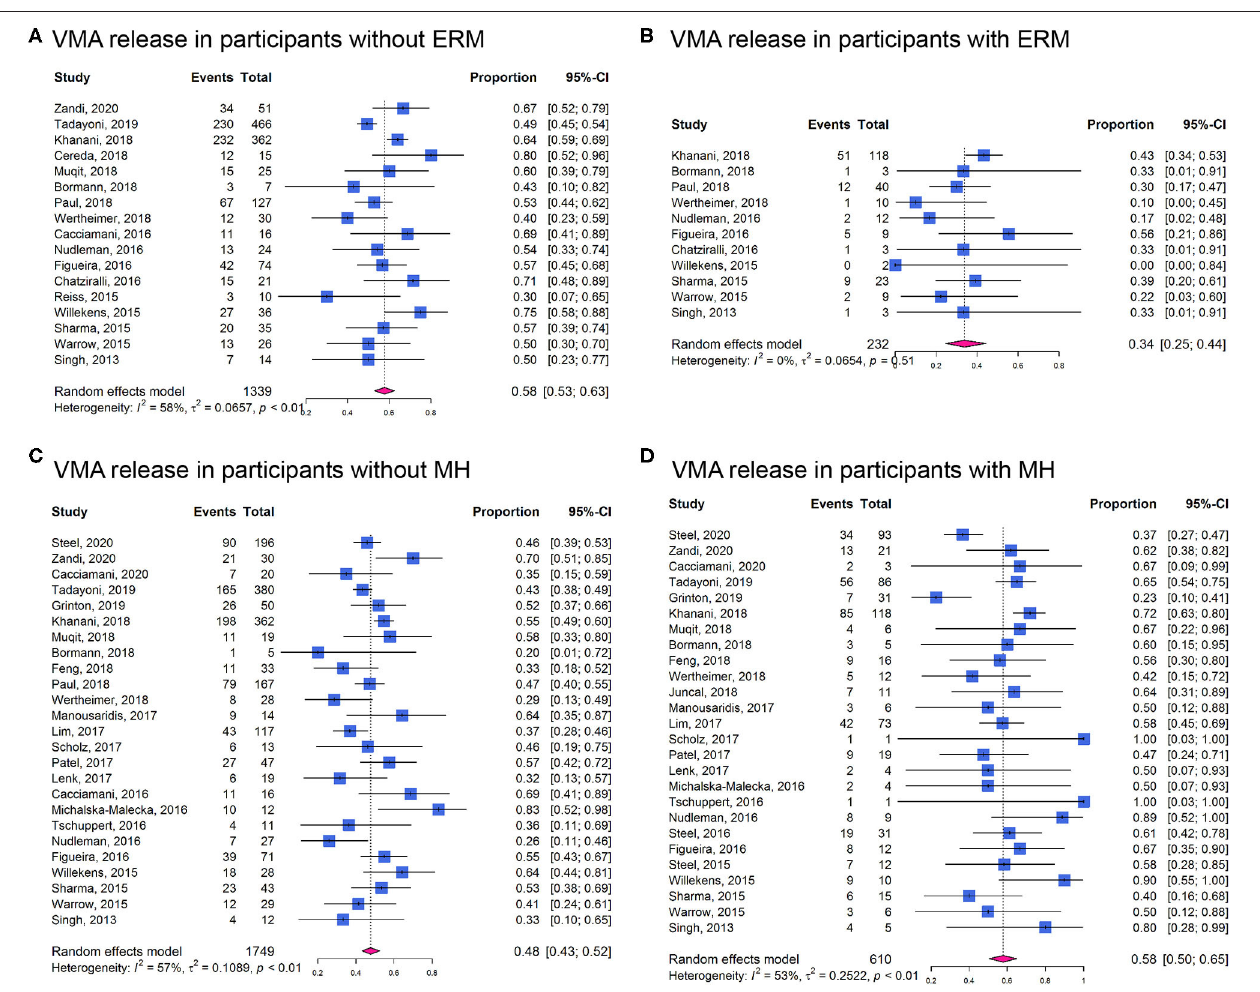
FIGURE 4 | Forest plots of proportion of VMA release in participants receiving ocriplasmin therapy in different groups. (A) In participants without epiretinal membrane (ERM); (B) In participants with ERM; (C) In participants without MH; (D) In participants with MH.